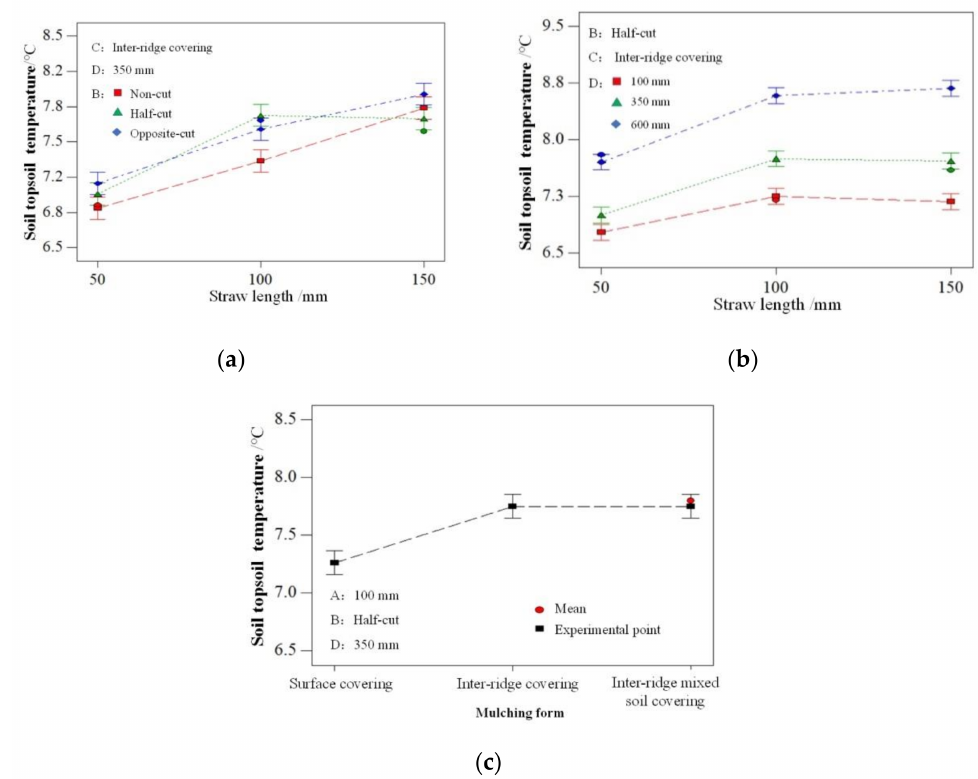
Figure 6. Influence of various factors on soil topsoil temperature; ( a ) the effect of interaction between straw length and straw shape on soil topsoil temperature; ( b ) effect of interaction between straw length and stubble height on soil topsoil temperature; ( c ) the influence of mulching form on soil topsoil